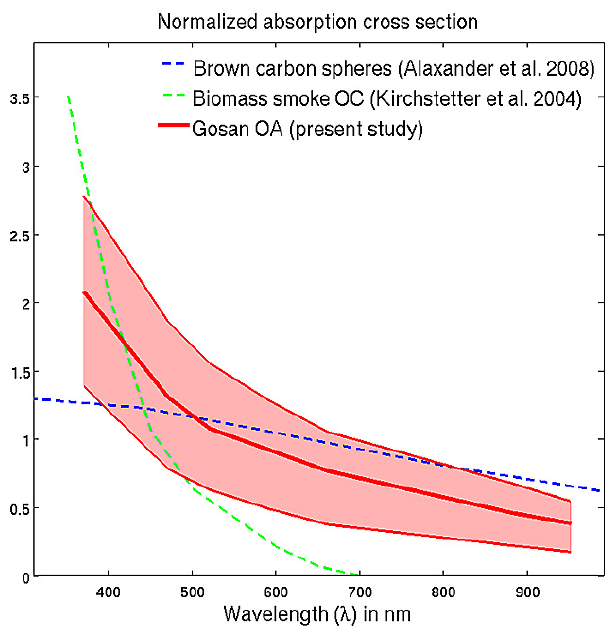
Fig. 9. Absorption cross section divided by its average w.r.t. wave- length. Biomass smoke OC refers to organic material (and not or- ganic aerosol) in biomass burning aerosols. In this case, OC absorp- tion was estimated by removing the OC component in the aerosol samples and measuring the absorption for the remaining aerosols. Gosan OA is represented by a thick red line (corresponding to our standard estimate) and shading. This shading shows the uncertainty of our estimate due to data shortage and uncertainties in the chosen parameters for data